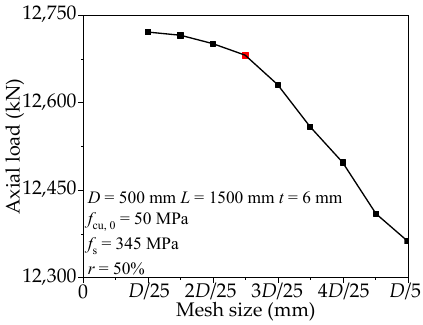
Figure 1. Axial load–mesh size curve.